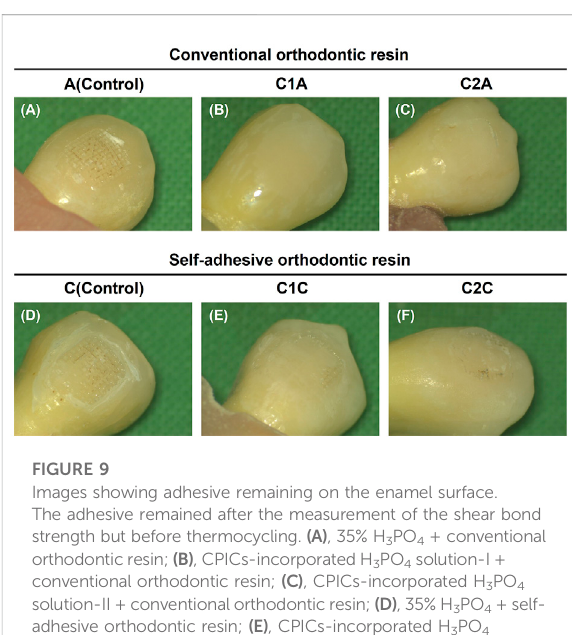
FIGURE 9 Images showing adhesive remaining on the enamel surface. The adhesive remained after the measurement of the shear bond strength but before thermocycling. (A) , 35% H 3 PO 4 + conventional orthodonticresin; (B) , CPICs-incorporated H 3 PO 4 solution-I + conventional orthodontic resin; (C) , CPICs-incorporated H 3 PO 4 solution-II + conventional orthodonticresin; (D) , 35%H 3 PO 4 + self- adhesive orthodontic resin; (E) , CPICs-incorporated H 3 PO 4 solution-I + self-adhesive orthodontic resin; (F) , CPICs- incorporated H 3 PO 4 solution-II + self-adhesive orthodontic